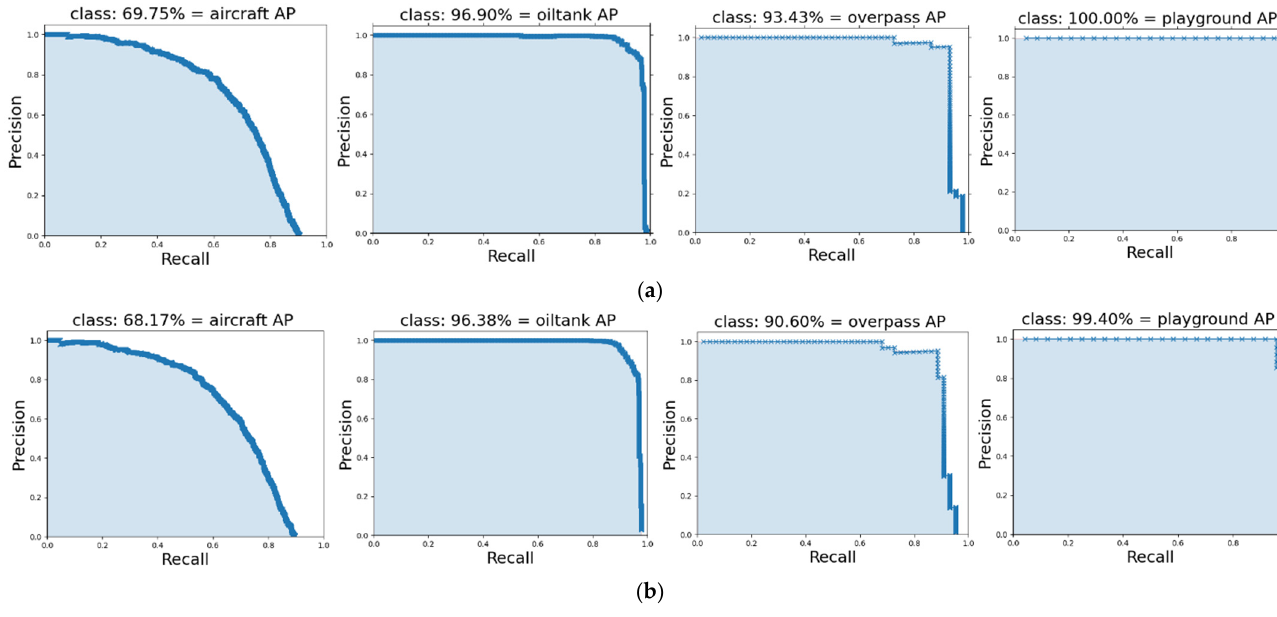
Figure 7. PR curves of RSOD dataset for various categories. ( a ) AFADet-300. ( b ) SSD.